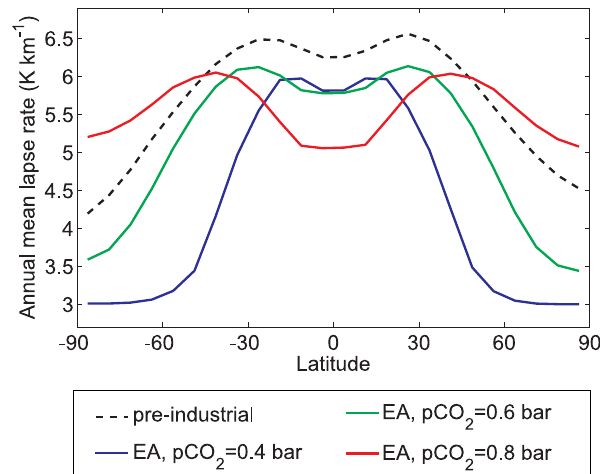
Fig. 10. Annual and zonal mean lapse rate for the following states: pre-industrial with the technical modifications from Sect. 2.3.3 (black), the critical state of the early Archean ( p CO 2 =0.4bar, blue), the state of the early Archean with present-day mean SAT of 288K ( p CO 2 =0.6bar, green) and an ice-free state ( p CO 2 =0.8bar,